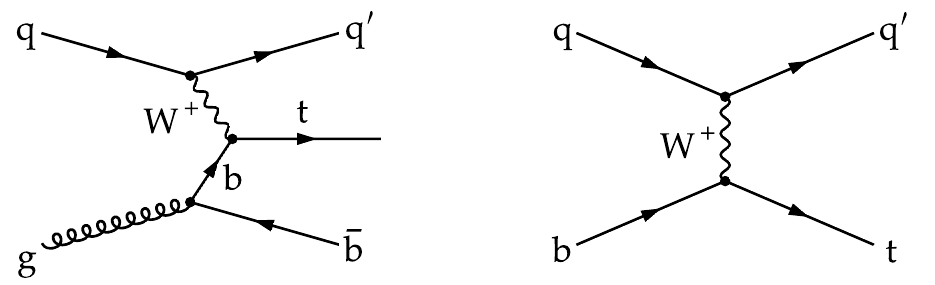
Figure 1 . Feynman diagrams of the t -channel single top quark production at LO corresponding to four- (left) and five-flavor (right) schemes. At NLO in perturbative QCD, the left diagram is also part of the five-flavor